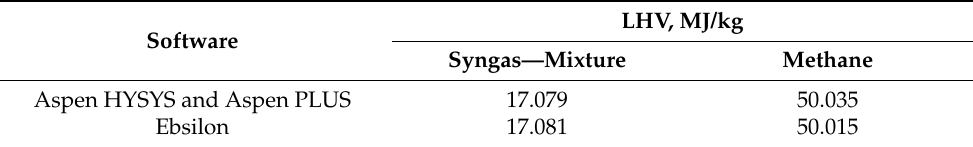
Figure 5. Fuel compositions for the analysed cycle. Table 6. LHV based on ISO 6976:1995(E) for gas mixtures, value at 15 ◦ C and 1 atm derived from Aspen and